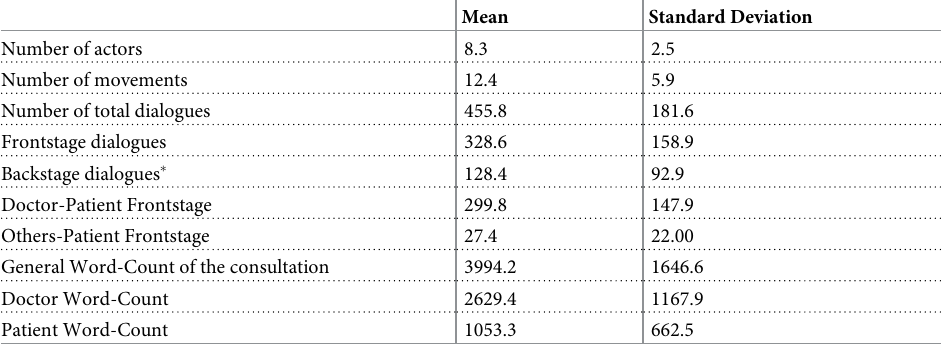
Table 1. Distribution of variables describing the setting of consultation and exchange of information (mean ± stan- dard deviation of the number of events per each visit).